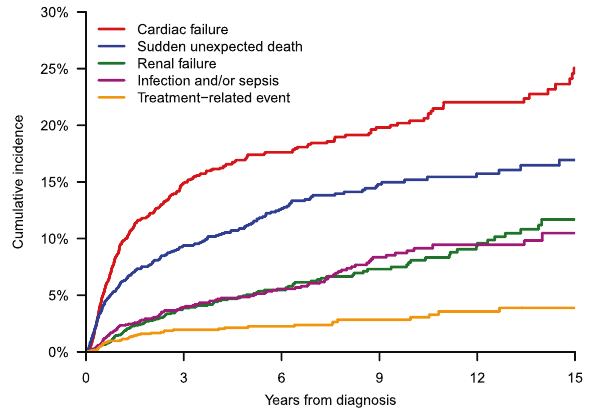
Fig. 3 Cumulative incidences of the top causes of death across disease course. The rate of cardiac failure and sudden unexpected deaths decreased with longer survival time from